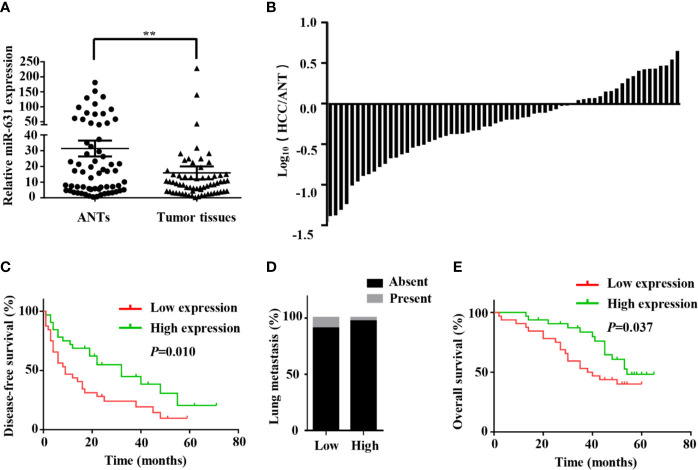
miR-631 is downregulated in tumor tissues of HCC. (A) miR-631 expressions in 64 paired HCC tissues and ANTs, measured by qRT-PCR and unit of U6. The data were analyzed by the delta Ct method on a logarithmic scale and compared by paired Student’s t-test. (B) The bars represent relative miR-631 expression with the ratio of its level in HCC tissue versus ANT in a logarithmic scale of 64 paired HCC patients. (C) Kaplan–Meier survival curves showed that the expression of miR-631 was associated with the disease-free survival of HCC. (D) There is no significant difference between the expression of miR-631 and lung metastasis. (E) The expression of miR-631 was associated with the overall survival of HCC analyzed by Kaplan–Meier survival curves. **P < 0.01.